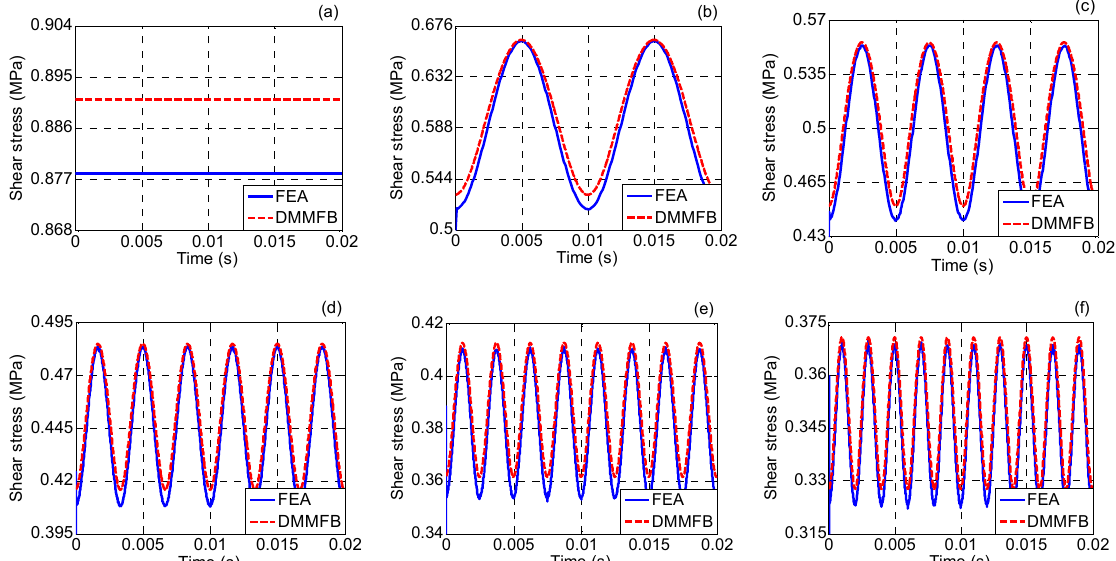
Figure 9. The shear stress at the internal wall of the extrusion liquefier without and with 0.3 g vibration applied at different frequencies. ( a ) No vibration applied, ( b ) 100 Hz, ( c ) 200 Hz, ( d ) 300 Hz, ( e ) 400 Hz, ( f ) 500 Hz.